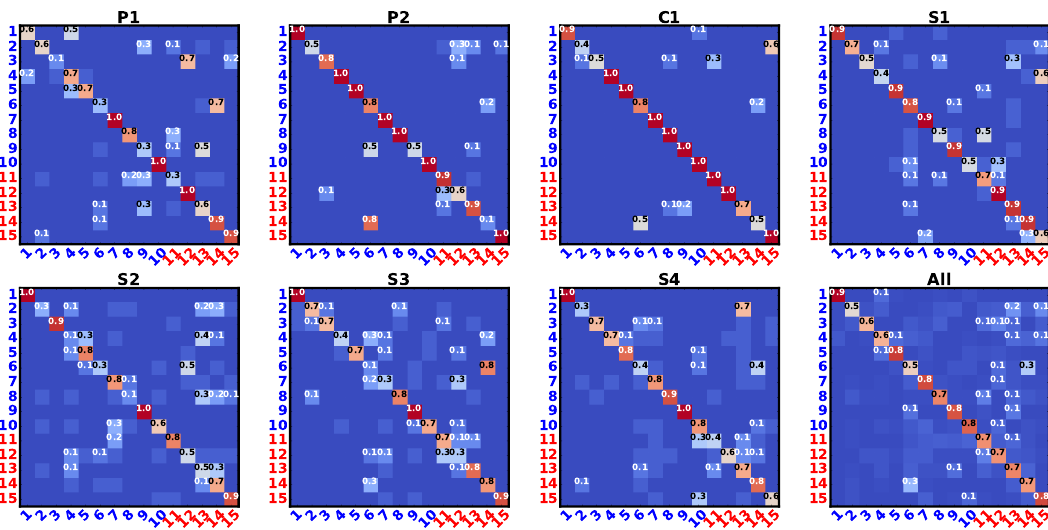
Figure 10. object confusion matrices (value normalized between 0 and 1) for each exploratory action and the average. The blue indices represent the old objects. The red indices represent the new objects, with #11–#15 indicating new objects #1–#5. Best viewed in magnification.